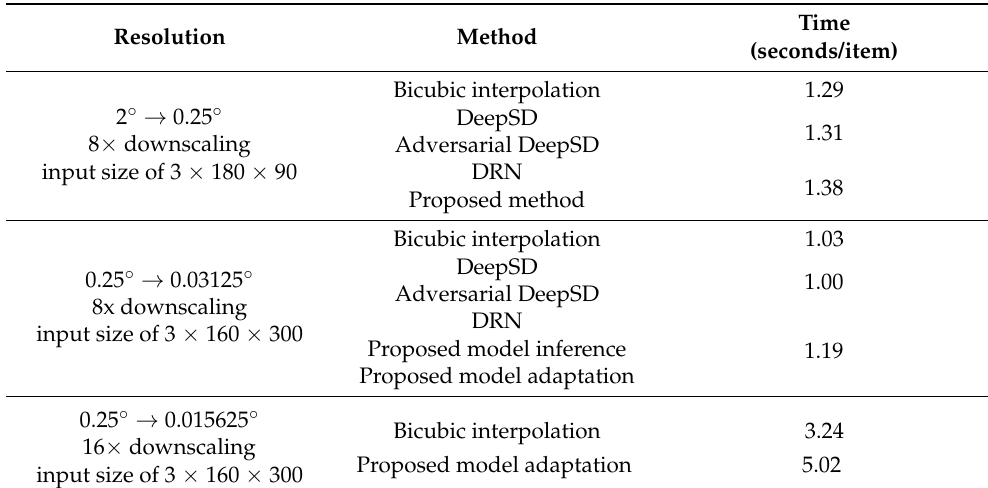
Table 8. The execution time of the (primal) model during model